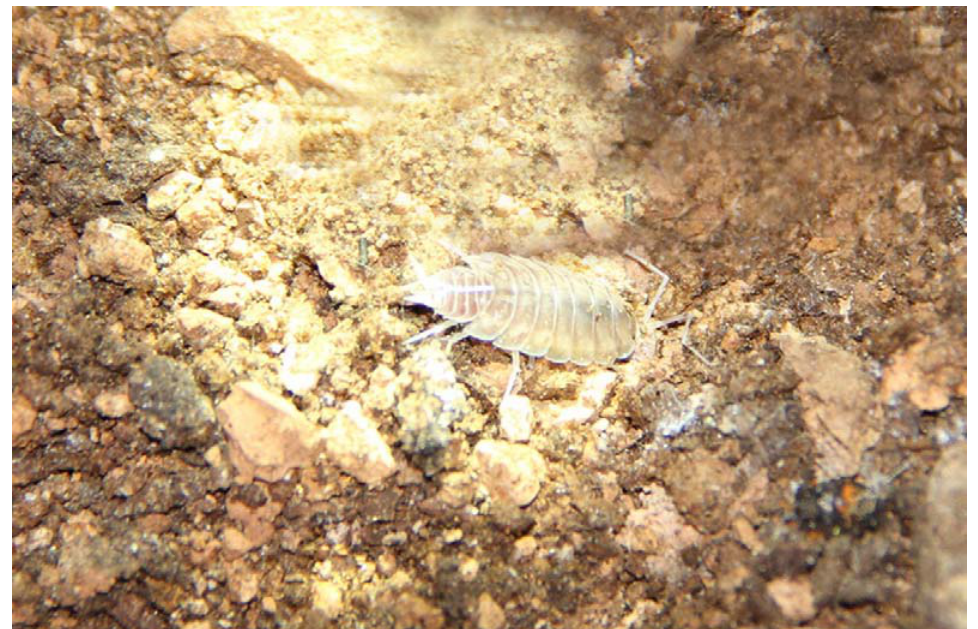
R ESULTS Family Agnaridae Schmidt, 2002 Protracheoniscus faramarzi n.